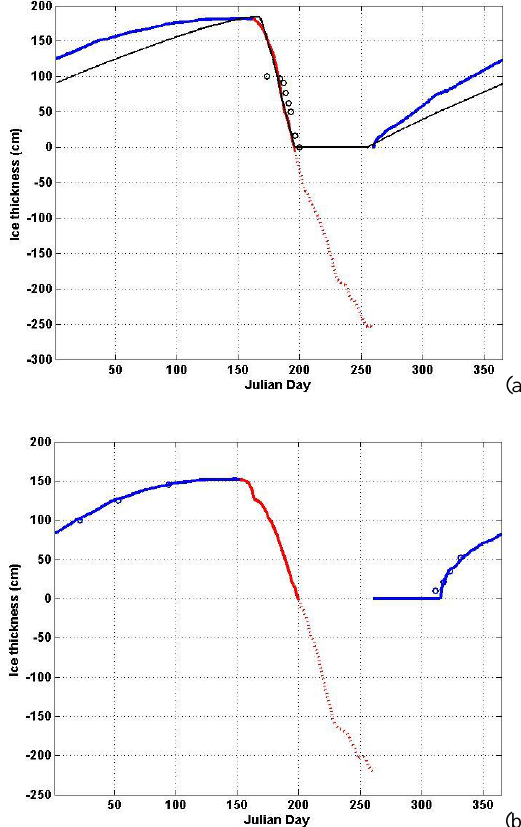
Figure 5. Modeled ice growth and decay calibration. In both plots, blue represents ice growth (Eq. 1) and red represents ice melt (Eq. 2). Fall freeze-up temperatures are from the preceding year but presented like this to highlight summer dynamics. Dotted red lines indicate how much more ice would have been melted, if it were present at end of winter. In A, the black line shows our energy- balance modeling results from 1999-2001 and black circles are percentage of ice-covered area on the lake from 2001 remote-sensing, using the ice thickness scale of 100 cm as 100%. Here we have fit the tuning parameters of Eq. 2 to match the melt rate of the previous model. In B, we have tuned parameters of Eq. 1 to match the growth rate measurements from 2009 (blue circles).